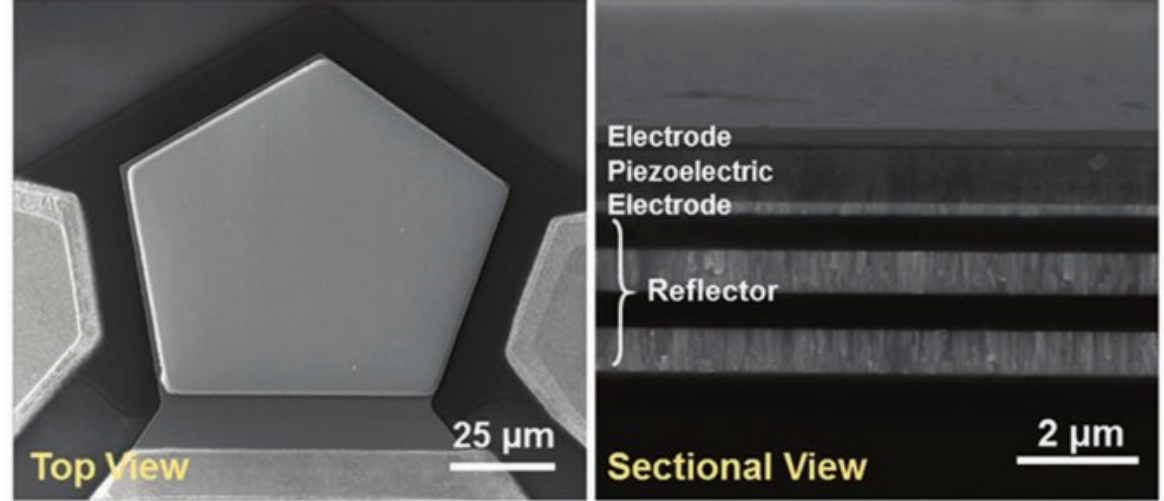
Figure 12. The top and the sectional view of the SEM images of the polygonal hypersonic resonator. Adapted with permission from [119].